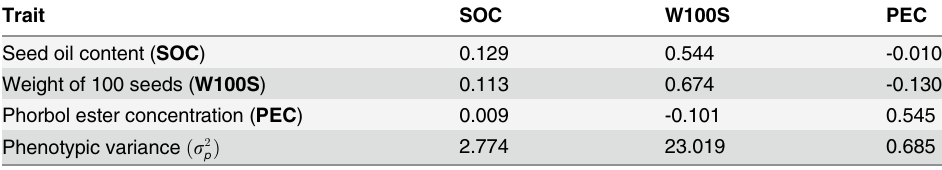
negative genotypic correlation was observed between PEC and SOC, and between PEC and W100S . Genetic diversity Genetic diversity analysis aimed to evaluate how the genotypes were distributed between the clusters. In this analysis we used the Ward clustering method based on the Mahalanobis dis- tance, which was calculated using the genotypic values estimated under a Bayesian multi-trait mixed models. Nine clusters were suggested according to the Ward method: six big clusters with 35, 31, 28, 23, 24 and 22 half-sib families; one cluster with 13 half-sib families; and two small clusters with 3 and 1 half-sib families (Fig 2). Phenotypic and genotypic distribution of the nine clusters suggested by the Ward clustering method can be verified in Fig 3. We observed that the use of genotypic values enables a well- defined clustering of genotypes, which is not observed when evaluating the phenotypic values using the clusters suggested by the clustering method. In other words, despite the high Table 2. Heritability (diagonal), genotypic (above) and phenotypic (below) correlation between traits. Trait SOC W100S